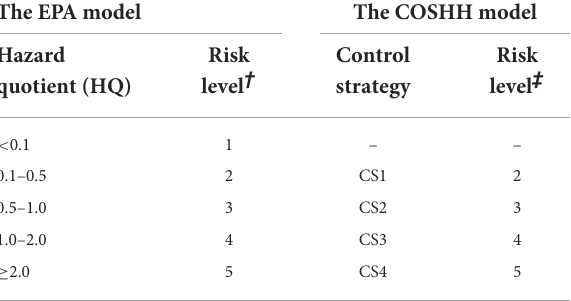
TABLE 2 Conversion of risk assessment results for the EPA and COSHH